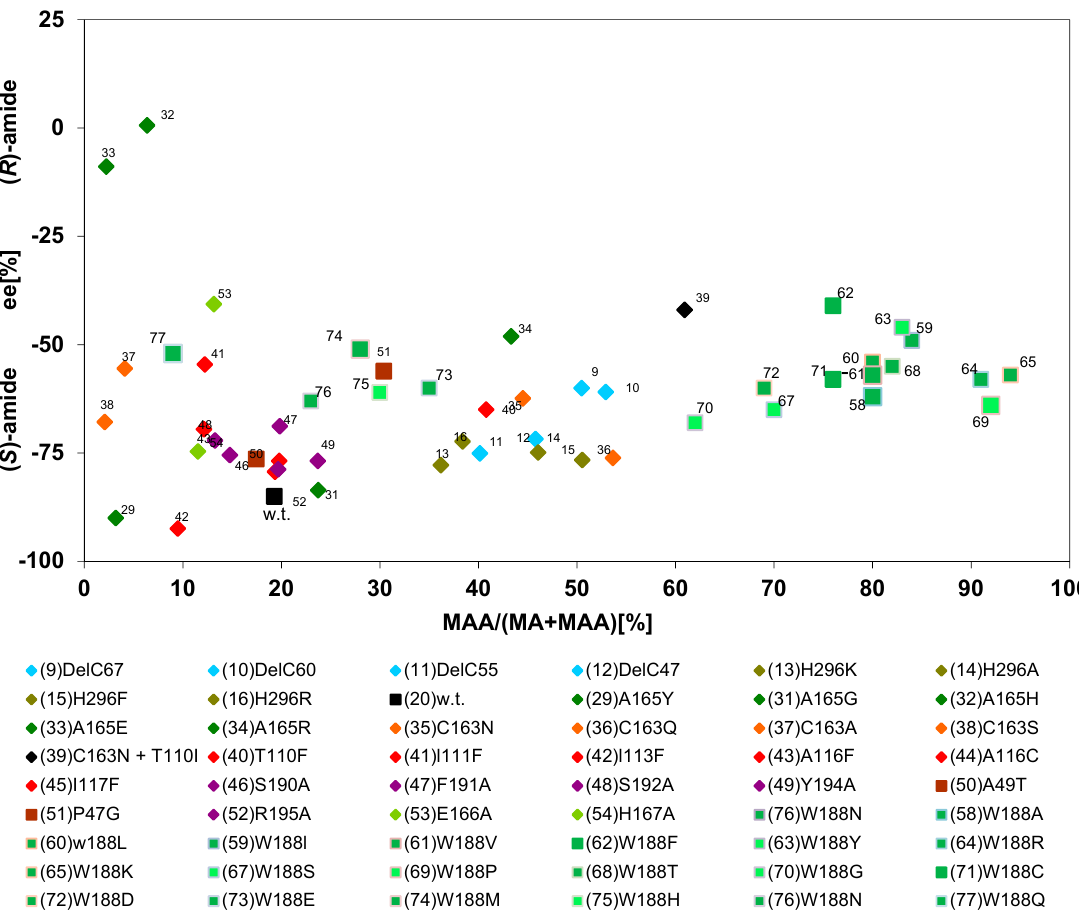
Figure 8. Relationship between the amounts of mandelamide formed from ( R , S )-mandelonitrile and the enantiomeric composition of the formed amide. The data were taken from previous publications (see Figure 6). In order to exclude errors from inaccurate measurements only those reactions were analysed in which more than 2% of mandelamide were formed from ( R , S )-mandelonitrile.